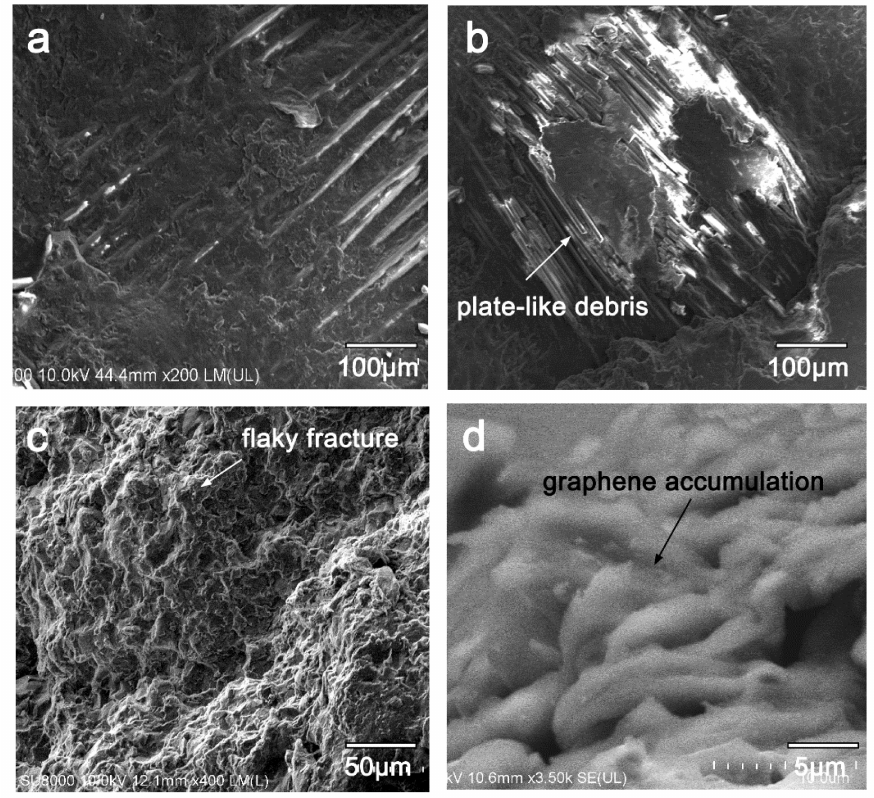
Figure12. RepresentativescanningelectronmicrographsofwornsurfacesofC-0.4g: ( a , b )Enlargedview of worn surface in Sections 1 and 2 (from Figure 11c), ( c , d ) lateral observation of the coating